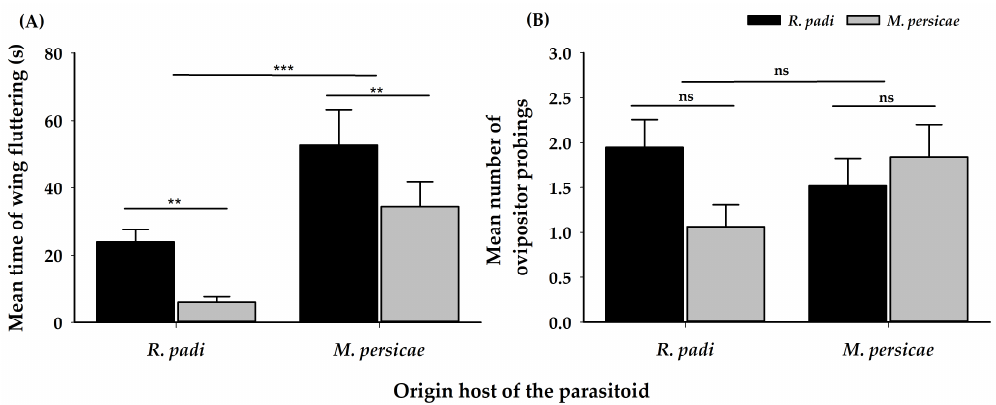
Figure 2. ( A ) Mean time wing fluttering ( ± SE) in seconds, and ( B ), mean number of ovipositor probings (±SE) of A. platensis from two origins ( R. padi and M. persicae ) exposed to these aphid hosts in a paired arena. Asterisks indicate significant differences: ‘***’ p < 0.001, ‘**’ p < 0.01 ‘*’ p < 0.05, ‘ns’ non-significant p > 0.05. Black and grey bars show the chosen/tested host.